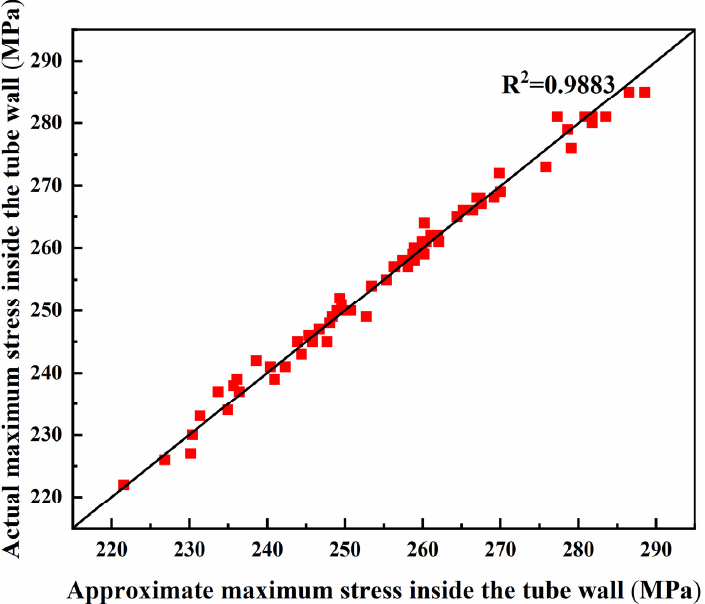
Figure 5. Error analysis results of the maximum stress inside the tube wall as the model output.